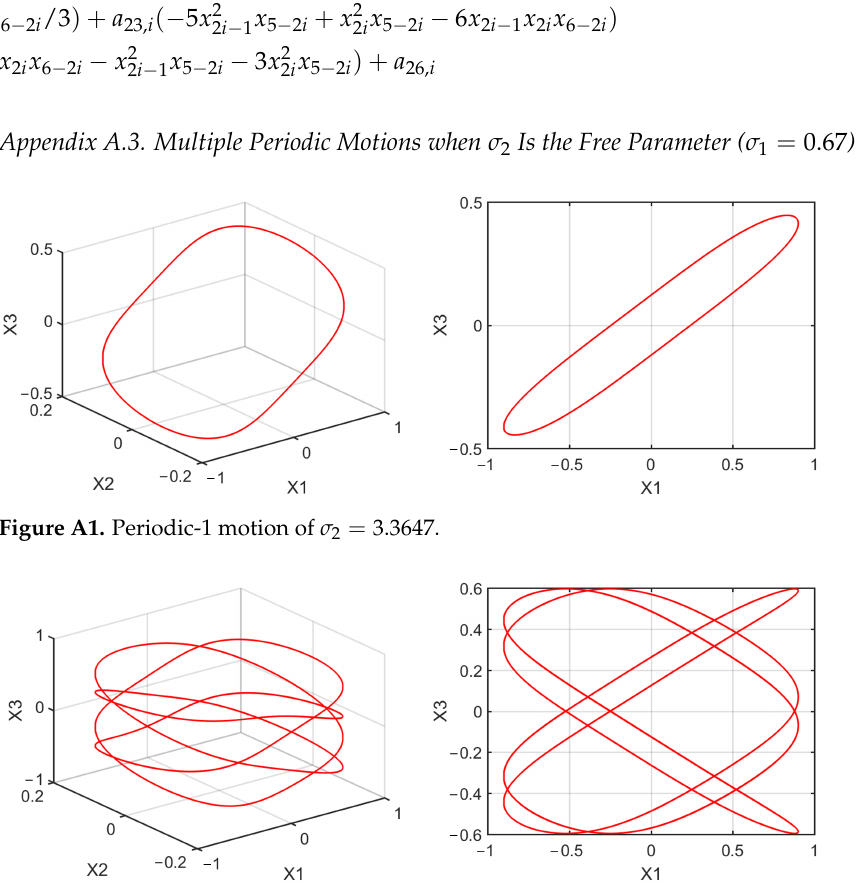
Figure A2. Periodic-4 motion of σ 2 =